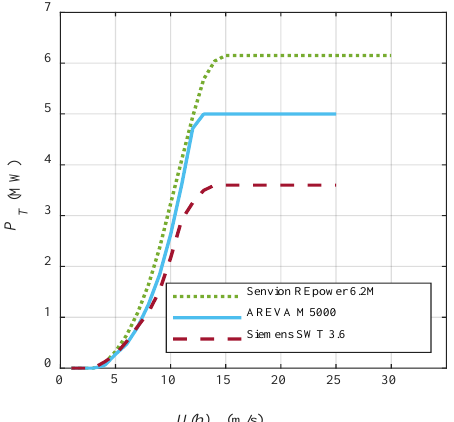
Figure 4. Power curves of the three wind turbines considered (data source: [44]). Table 1. Technical specifications of the wind turbines considered (data source: [44]). Parameter